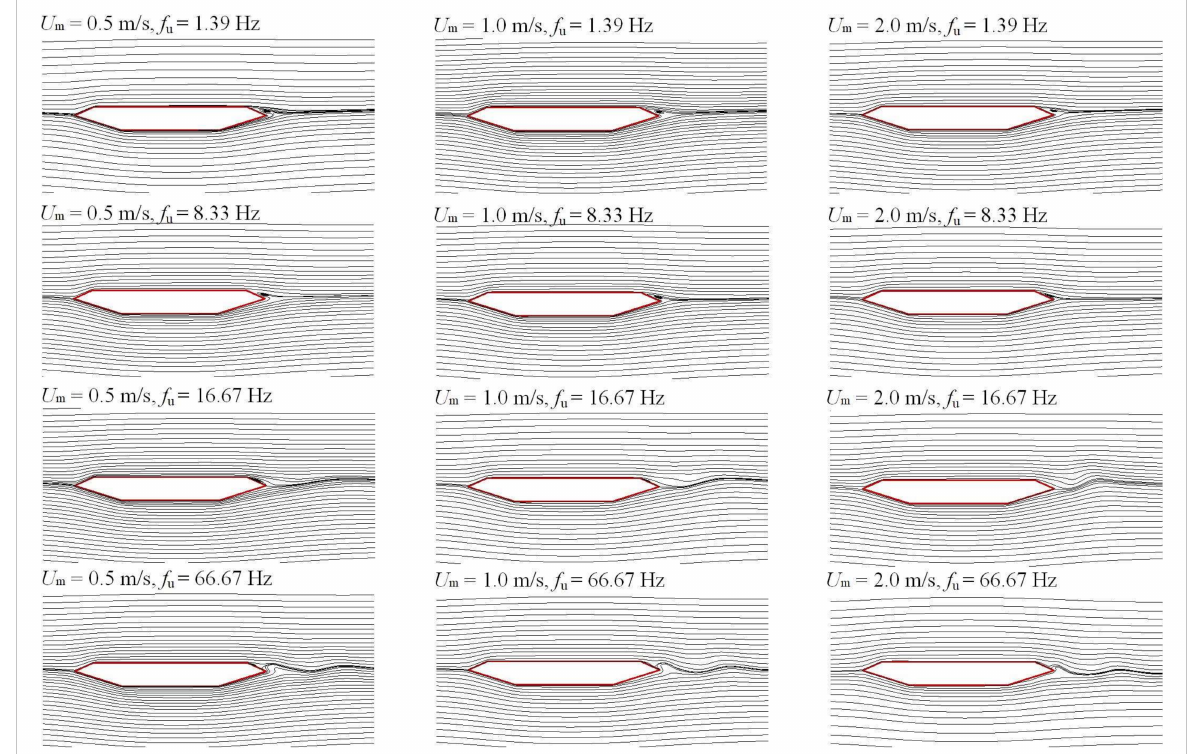
Figure 14. The effect of U m and f u on time-averaged stream line distributions in streamwise oscillat- ing